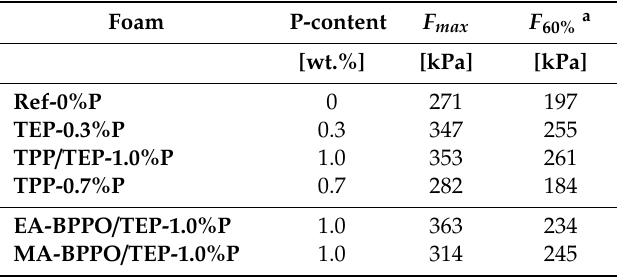
Table 4. Mechanical properties of selected